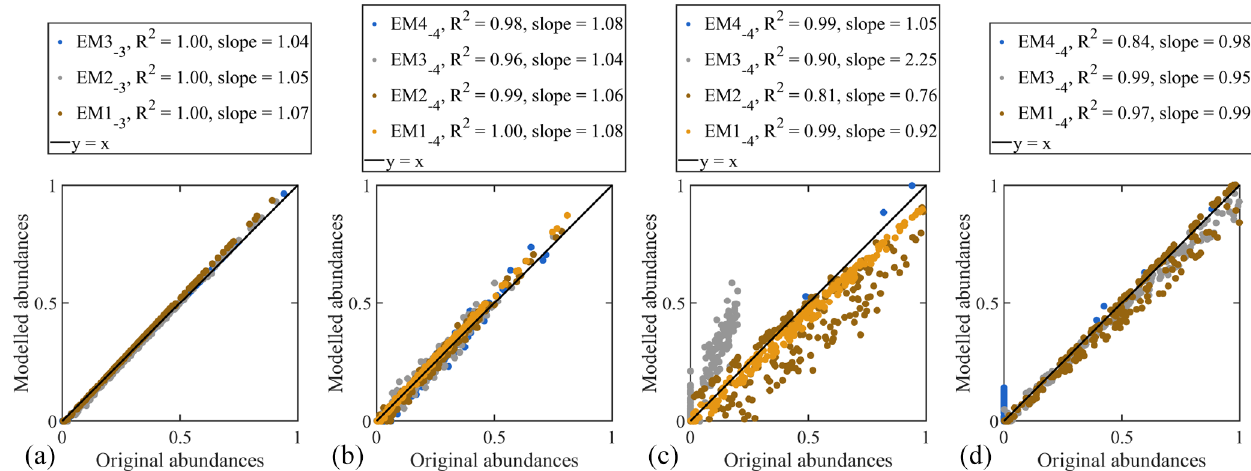
Figure A7. A comparison of modelled and input endmember abundance for the artificial datasets ( a : 3EM solution for 3EM_nonoise, b : 4EM solution for 4EM_noise, c : 4EM solution for 4EM_noise_highmix, d : 4EM solution for 4EM_noise_highmix, but without the highly mixed endmember).